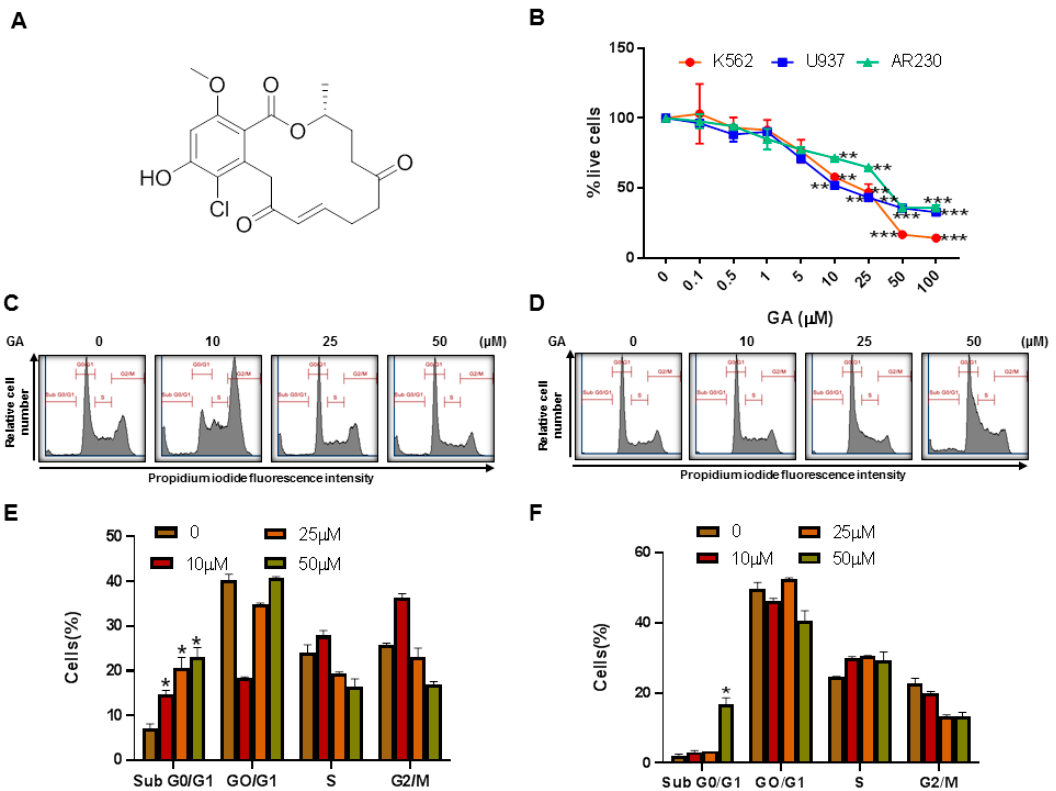
Figure 1. Effects of greensporone A (GA) – on cell proliferation and cell cycle . ( A ) Molecular structure of Greensporone A. ( B ) MTT assay was used to measure cell viability as mentioned in Section 2. Cell cycle fraction analysis of cells in response to GA. ( C ) K562 and ( D ) U937 cells were treated with GA, as indicated, and analyzed by flow cytometry. GA significantly enhanced SubG0 fraction in ( E ) K562 and ( F ) U937. The graph displays the mean ± SD of three independent experiments. * P < 0.05, ** P < 0.01, *** P < 0.001.